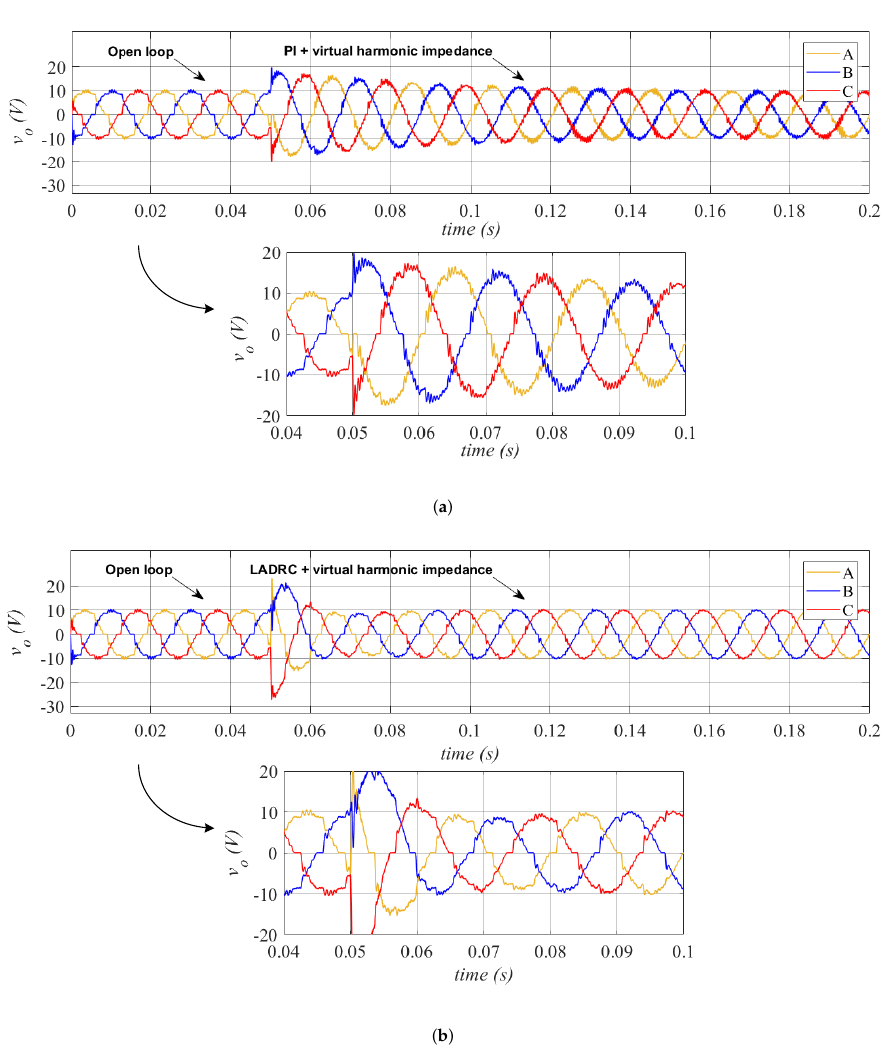
Figure 10. ( a ) The output voltage with PI and virtual harmonic impedance. ( b ) The output voltage with LADRC and virtual harmonic impedance.